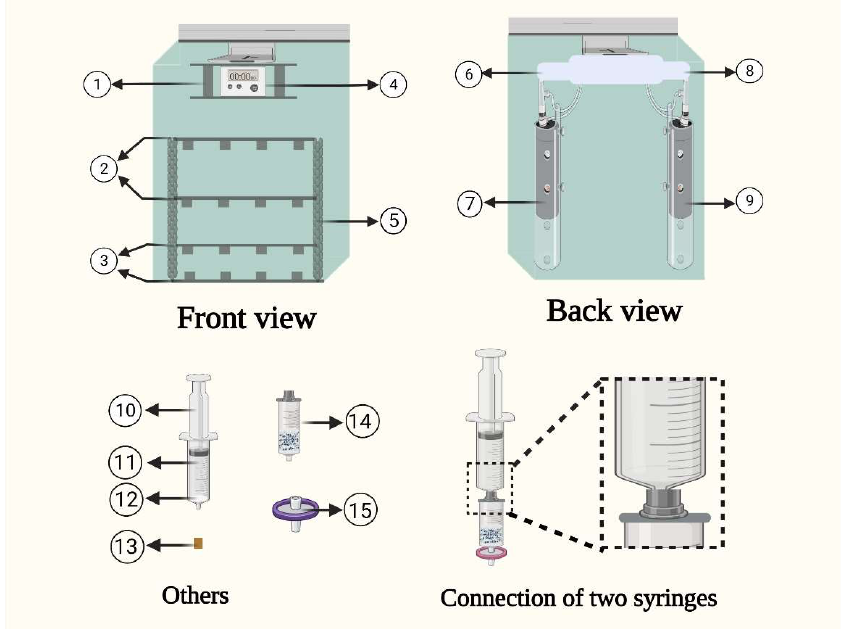
Figure 5. Illustration of the design of the developed semi-automated instrument for the FaMEx clean-up process. Parts numbers in this figure: 1. Plunger rods, 2. Extraction syringe holder, 3. Clean-up syringe holder, 4. Monitor, 5. Syringe stand, 6 and 8. Plunger controller, 7 and 9. Motor, 10. Plunger, 11. Extraction syringe barrel, 12. Hydrophobic frits, 13. Stopper for extraction syringe, 14. Clean-up syringe, and 15. Filter.